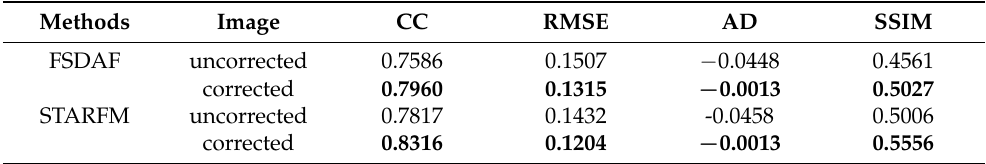
Table 2. Accuracy of the STARFM- and FSDAF-predicted NDVIs before and after bias correction of input data for the Gwydir area. Best results are marked in bold.